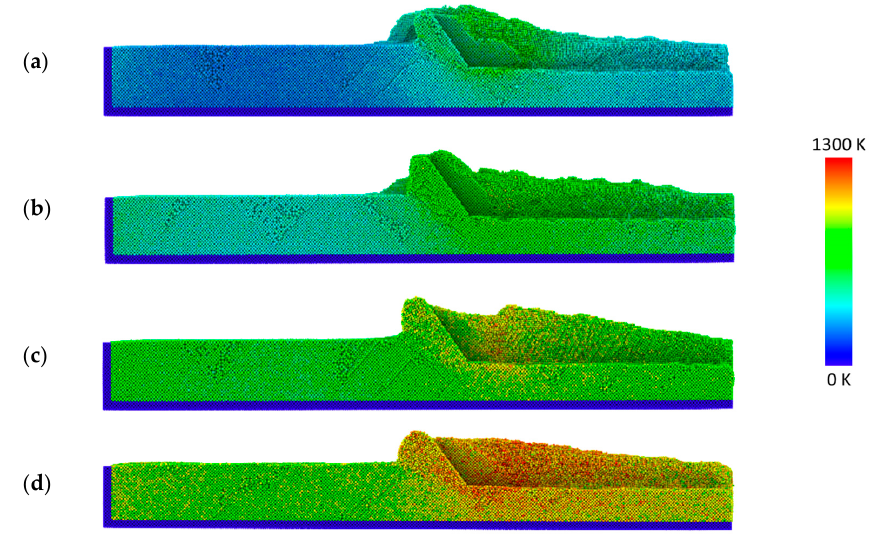
Figure 8. Workpiece temperature distribution for ( a ) T w = 300 K, ( b ) T w = 500 K, ( c ) T w = 700 K, and ( d ) T w = 900 K.